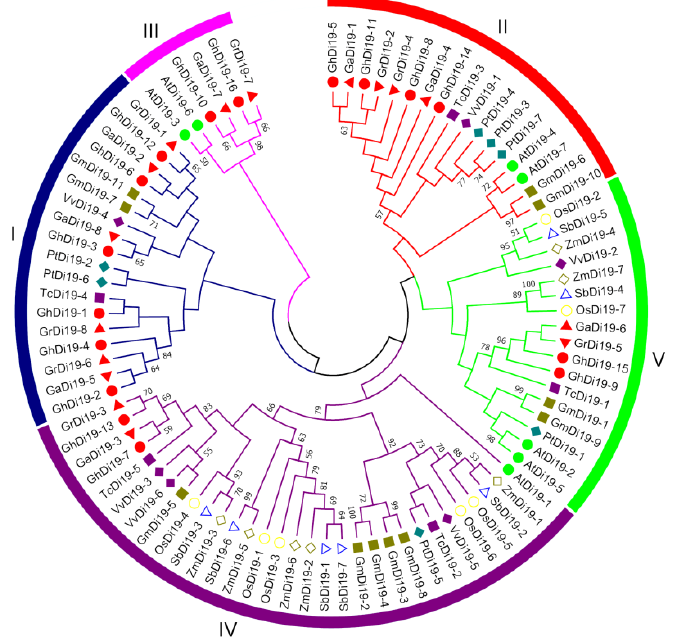
Figure 1. Phylogenic analysis of Di19 proteins in cotton and other plants. The neighbor-joining (NJ) phylogenetic tree was built with MEGA 7.0, and the bootstrap values from 1000 replicates are indicated at each branch. Each plant species was marked with different characters and colors. Di19 proteins of 11 plants were labeled with different colors and patterns.